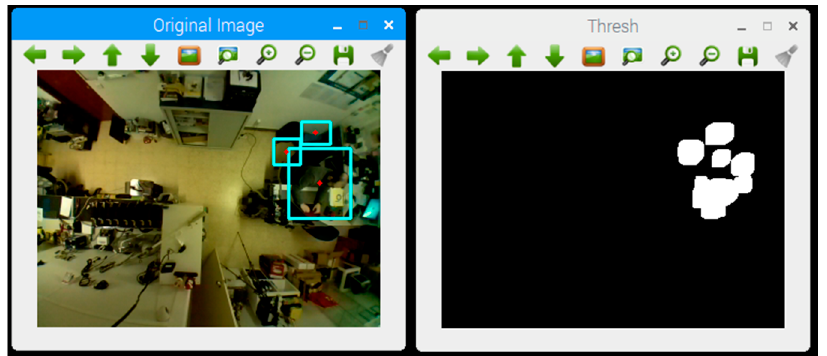
Figure 6. Motion detection in the image.